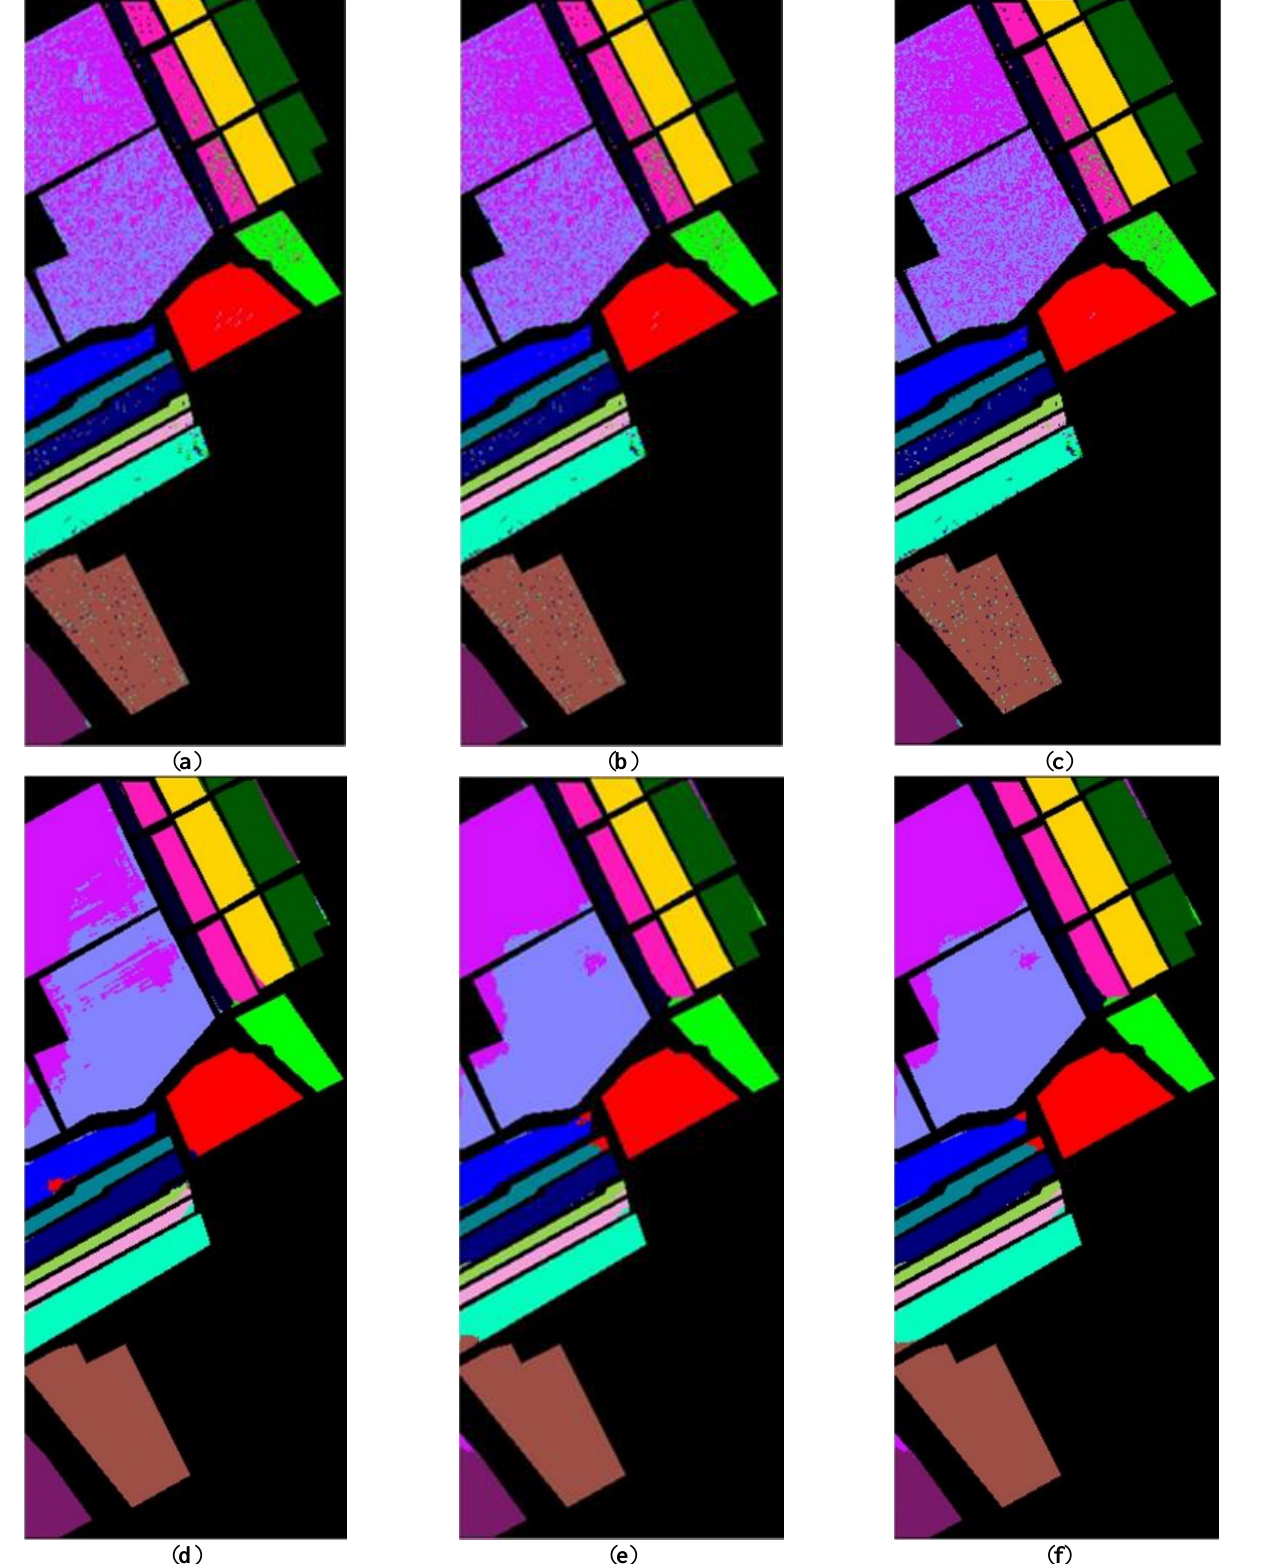
Figure 5. The classified label maps for dataset Salinas using three DM methods plus two classifiers. ( a ) (PCA, NN) ( b ) (PCA + FLE, NN), ( c ) (PCA + SVMFLE, NN), ( d ) (PCA, GAN) (Zhu’s method), ( e ) (PCA + FLE, GAN), and ( f ) (PCA + SVMFLE, GAN).